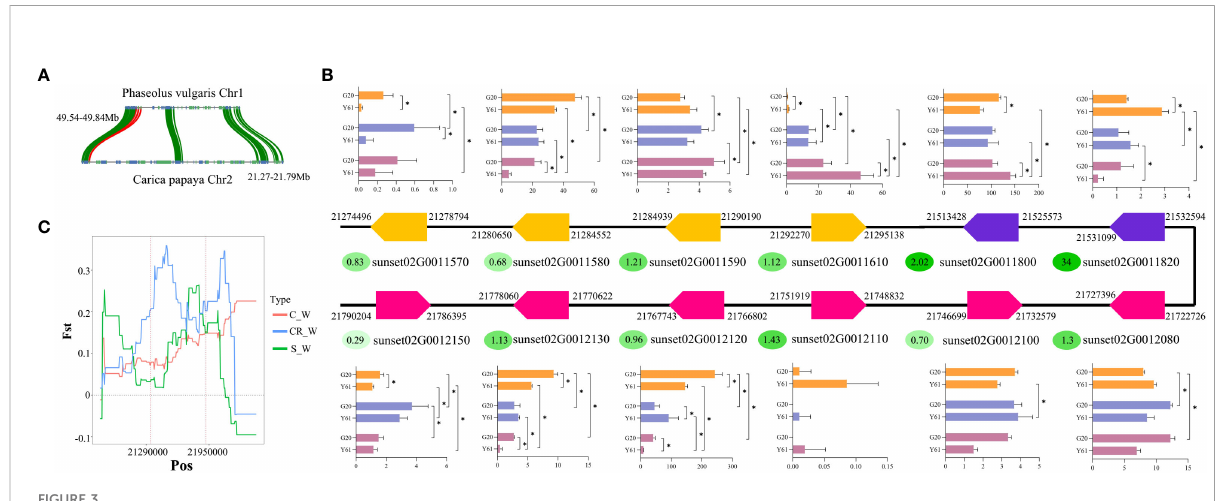
FIGURE 3 Analysis of gene clusters associated with anthracnose resistance. (A) Synteny of gene clusters associated with anthracnose resistance in common bean and papaya genomes. (B) Schematic representation of the arrangement of genes in a candidate gene cluster for anthracnose resistance in papaya. Arrows to the right indicate that the gene is in the forward orientation on the chromosome, while arrows to the left indicate that it is in the reverse orientation. The number in the oval next to each gene is the Ka/Ks value for that gene in the papaya population. The bar graphs indicate the expression level of a gene in different groups, with an asterisk indicating whether the gene is signi fi cantly differentially expressed between the two groups. The 3 different colours from the top to the bottom of the bar graph indicate 0, 24, and 48 hpi, respectively. (C) Fst values of the sunset02G0011610 gene in the gene cluster between different cultivar populations and the wild-type population. S indicates solo, CR indicates costa rican, C indicates common, and W indicates